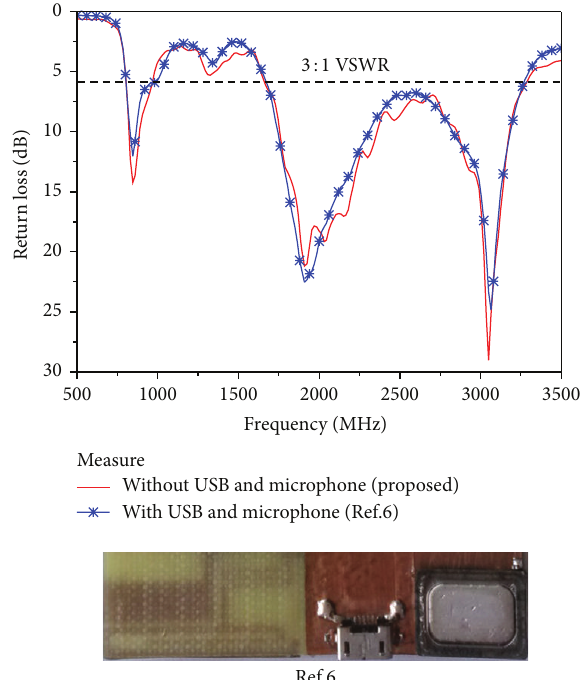
Figure 10: Comparison of measured return loss for the proposed antenna and the case with a USB and a microphone (Ref.6).